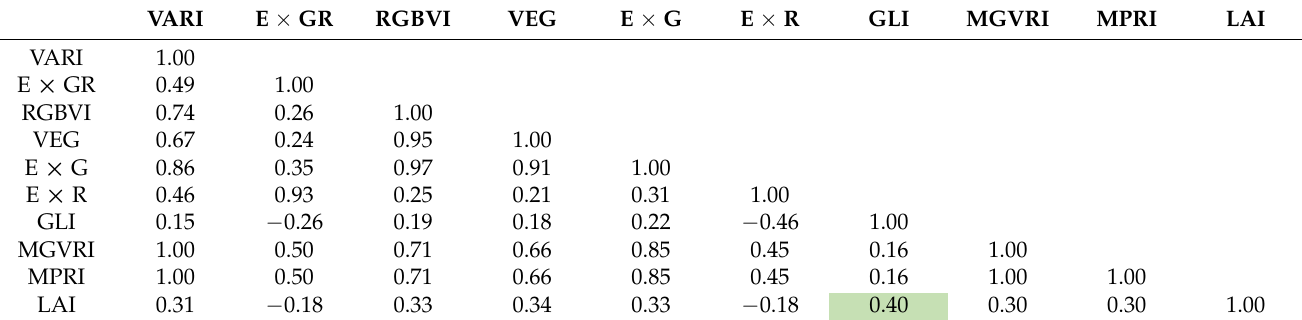
Table 5. Correlation between VIs and LAI in the fifth phase of the phenological cycle of the